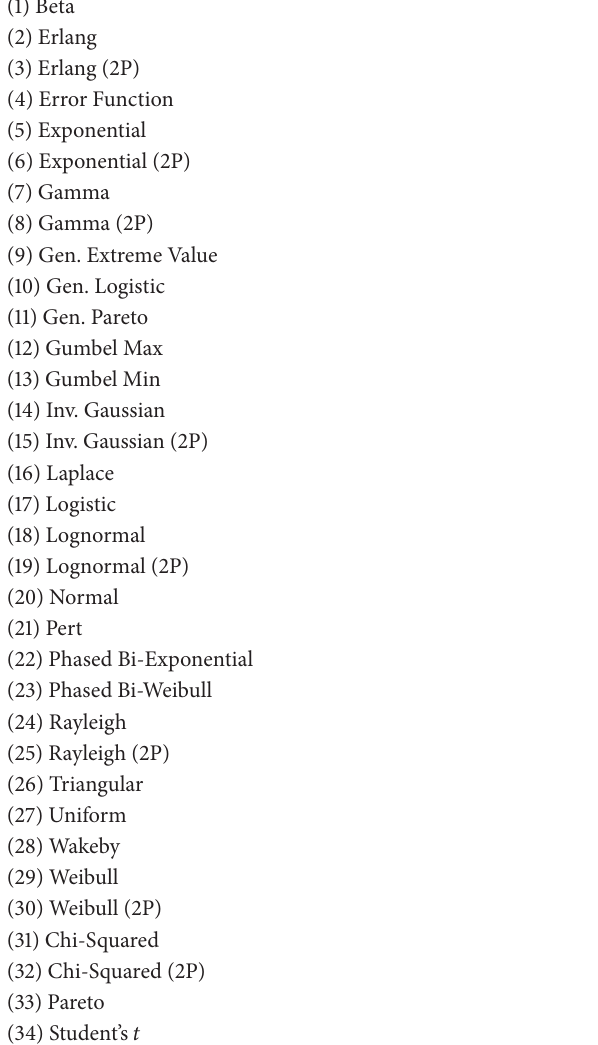
Table 1: Probability distributions fit to the historical climate